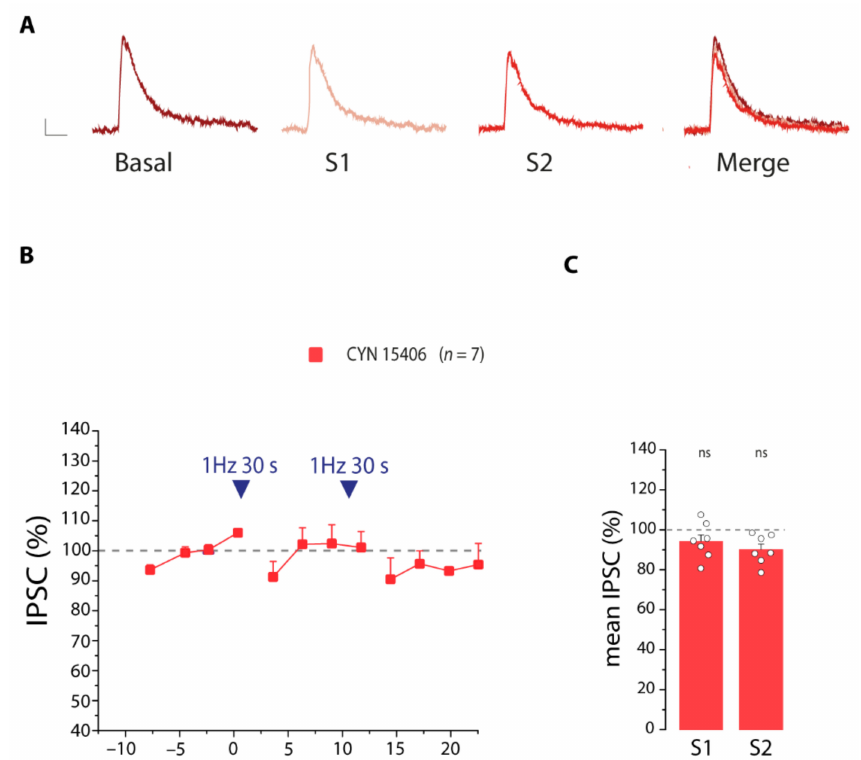
Figure 10. SST receptors participate to the mechanism of disinhibition of PNs. ( A ) Representative IPSCs recorded in the presence of the SSTRs antagonist CYN 15406, before (basal) and after the first (S1) and the second (S2) 30 light pulse stimulations. Scale bar 50 ms, 10 pA. ( B ) IPSCs amplitude before and after the 30 light pulse stimulation in the presence of the SSTR antagonist CYN 15406 ( n = 7). ( C ) Quantification of the disinhibition of PNs after the first (S1) and second (S2) stimulations, in the absence and presence of CYN 15406. Note that in the presence of CYN 15406, an intense stimulation of SST interneurons does not decrease significantly the inhibitory currents on PNs.